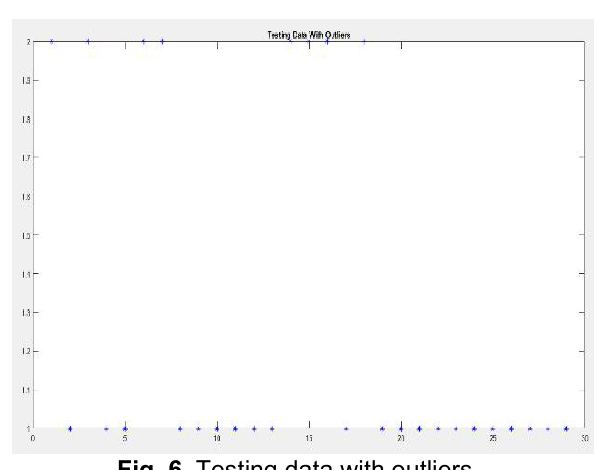
Fig. 6. Testing data with outliers Fig. 6 represents the test data set before the removal of outliers. Remaining 27 patient’s data out of 99 patient’s data are used as the testing data set